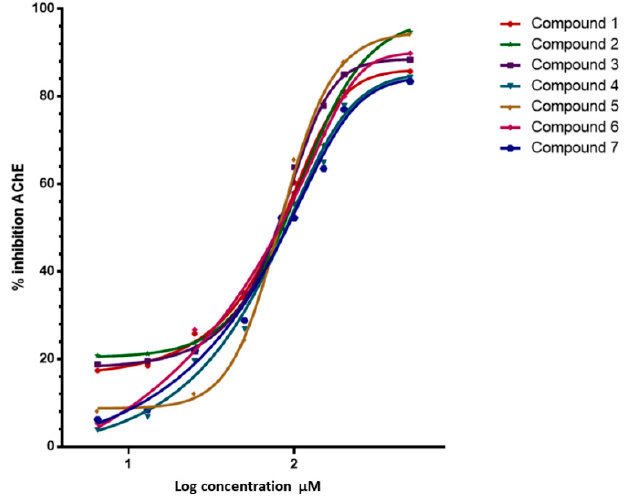
Figure 3. Inhibitory activitie of Ceanothanes 1 – 7 on AChE from Electrophorus electricus. Dose-de- pendent inhibitory activities of the seven compounds against AChE. The initial compound concen- tration was 50 µM and was subsequently diluted to get the set concentration of 0.0032, 0.016, 0.08, 0.40, 2.00, 10.00, and 50.00 µM. Galantamine was used as a positive control for AChE inhibition. Table 1. Inhibition of acetylcholinesterase (AChE from Electrophorus electricus, and human blood) and butyrylcholinesterase (BChE from equine serum) from Ellman ’ s assays, IC 50 , Ki, Moldock value, and inhibition type for ceanothanes 1 – 7 used in this study.